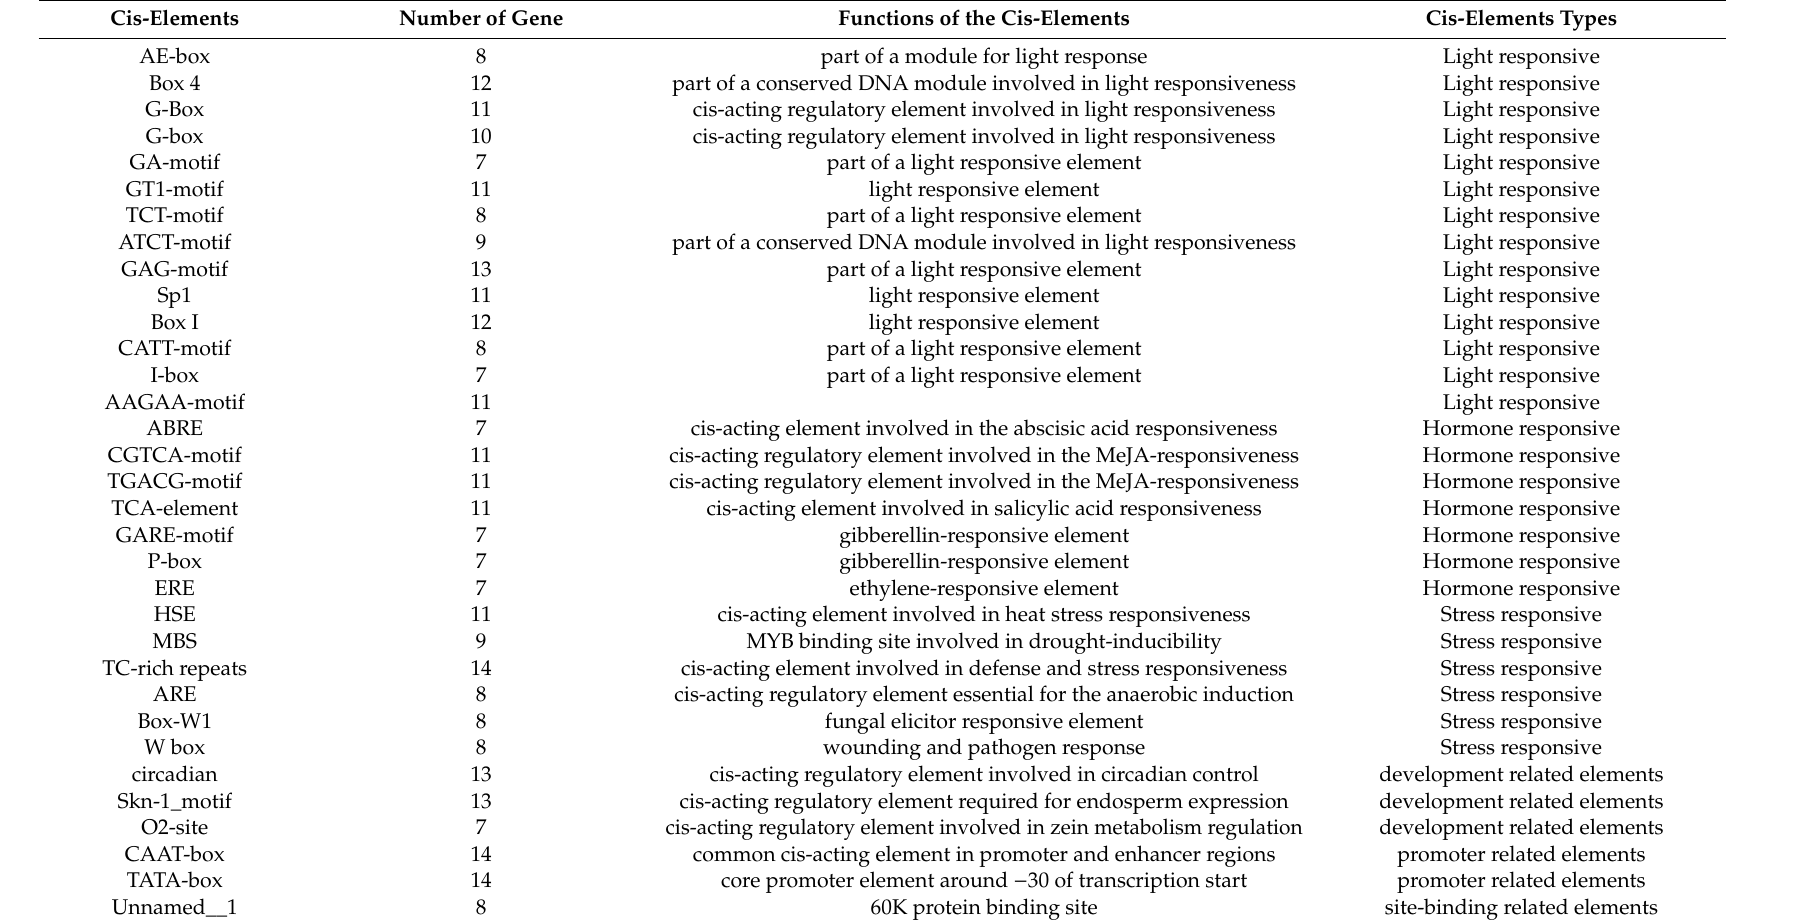
Table 3. Cis -elements present in more than seven promoters of PIN genes in